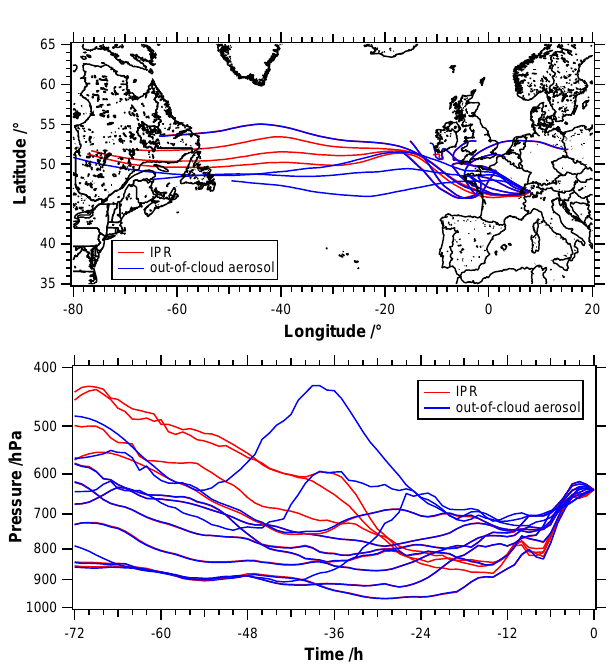
Figure 6. Back trajectories (above) and air mass pressure as a func- tion of time (below) for both sampling periods (red: IPR; blue: out- of-cloud